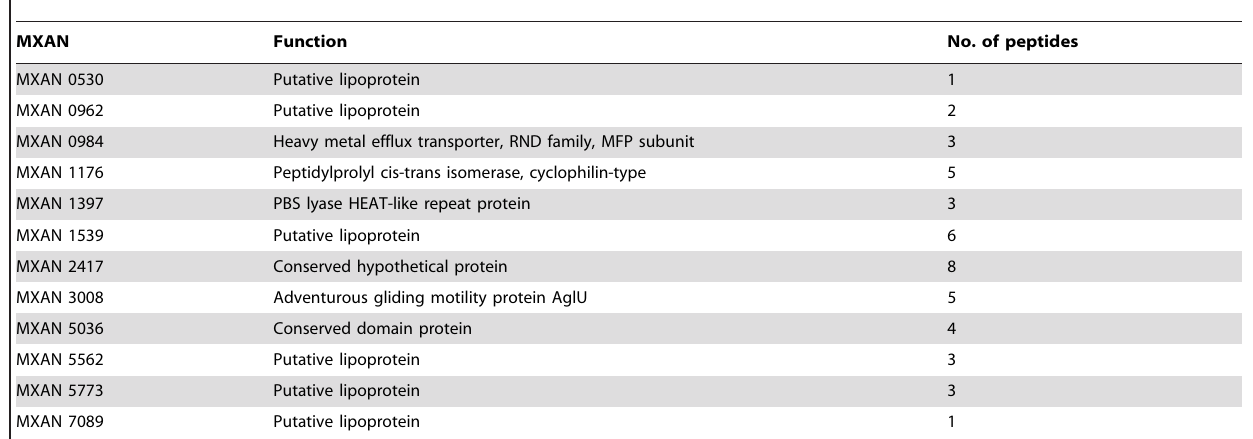
Table 5. Putative lipoproteins identified by LC-MS/MS from IM fraction.